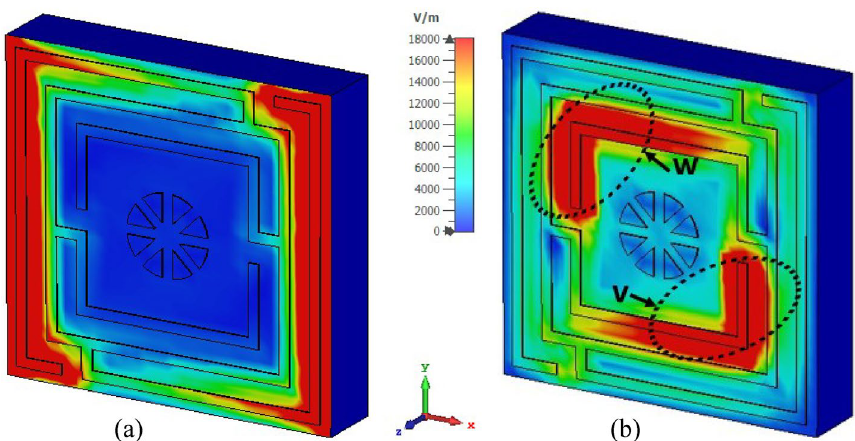
Figure 14. E-field distribution for the presented MM structure at ( a ) 3.37 GHz and ( b ) 5.8 GHz (CST STUDIO SUITE 2019, https:// www. 3ds. com/ produ cts- servi ces/ simul ia/ produ cts/ cst- studio- suite) 39